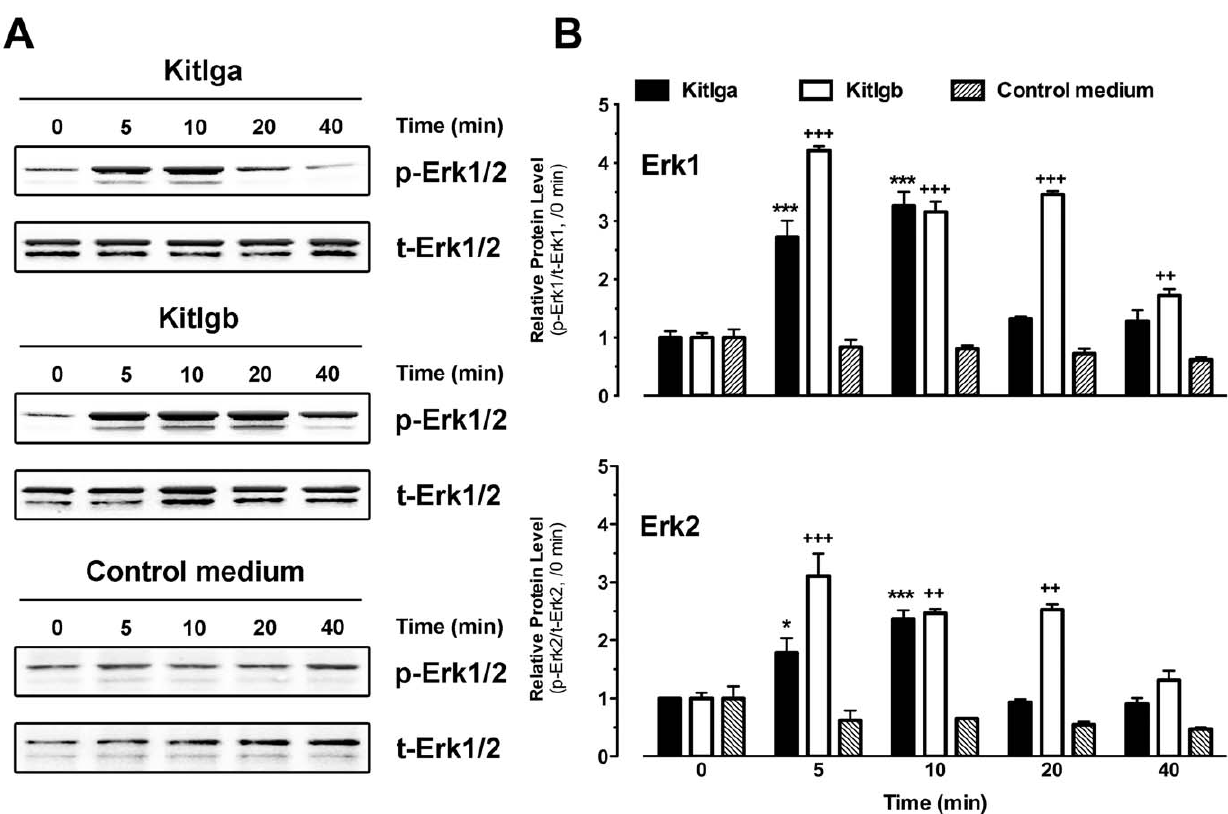
Figure 8. Effects of Kitlga and Kitlgb on MAPK phosphorylation in cultured follicle cells. (A) Western blot analysis of MAPK (Erk1/2) phosphorylation in response to Kitlga (200 m l Kitlga conditioned medium + 200 m l control medium per ml), Kitlgb (400 m l/ml Kitlgb conditioned medium) and control medium (400 m l per ml). (B) Densitometric quantification of Erk1 (upper) and Erk2 (lower) phosphorylation. The data were normalized to total Erk1 or Erk2 and expressed as the fold change compared to the first group at time 0 min (mean 6 SEM, n=3). */ + P , 0.05; **/ ++ P , 0.01; ***/ +++ P , 0.001. p-Erk1/2, phosphorylated Erk1/2; t-Erk1/2, total Erk1/2.